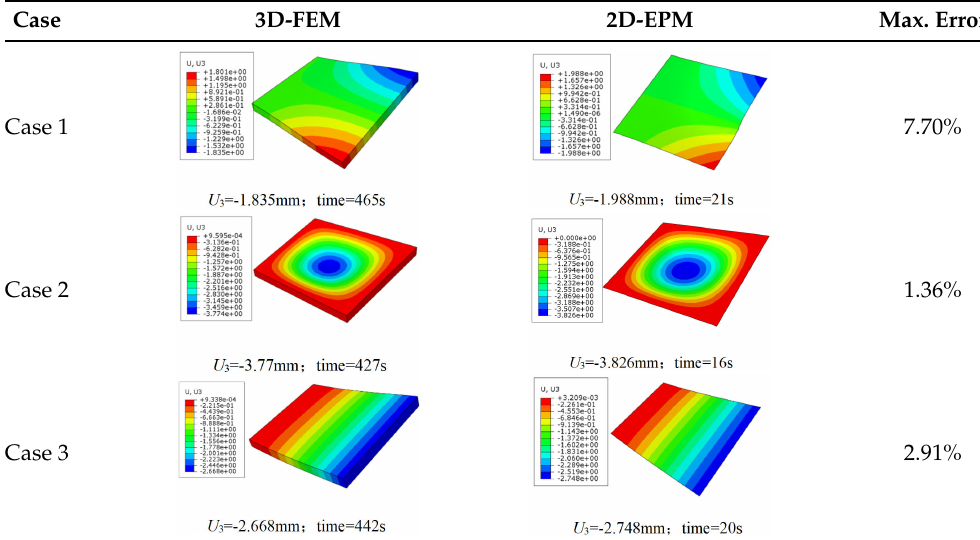
Figure 6. Combinations of boundary and load conditions for bending analysis. ( a ) Case 1; ( b ) Case 2; and ( c ) Case 3. Table 4. Comparison of displacement U 3 predicted by two models under various boundary and load conditions (unit: